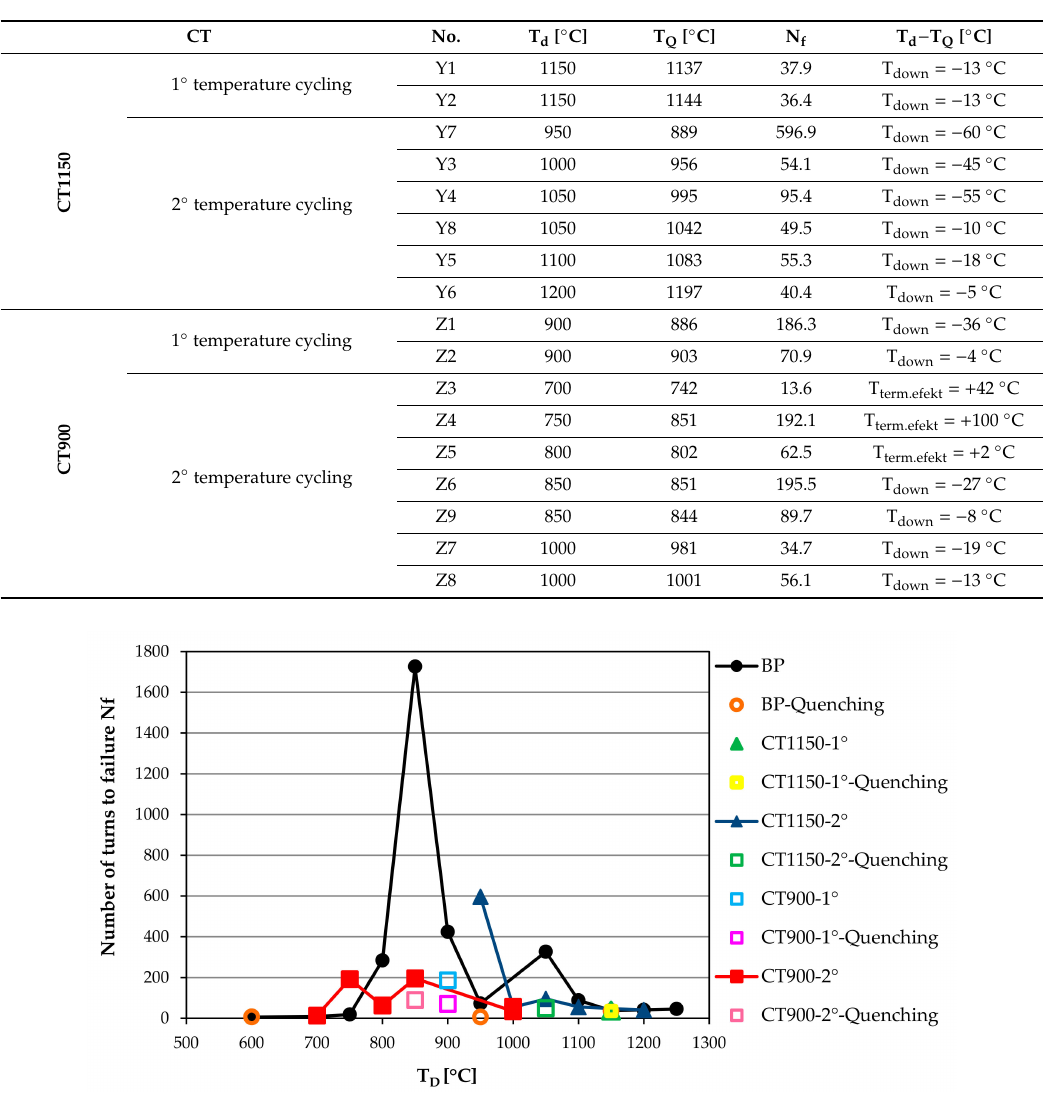
Table 5. Results of hot torsion testing with temperature cycling based on programmes (CT1150) and (CT900).